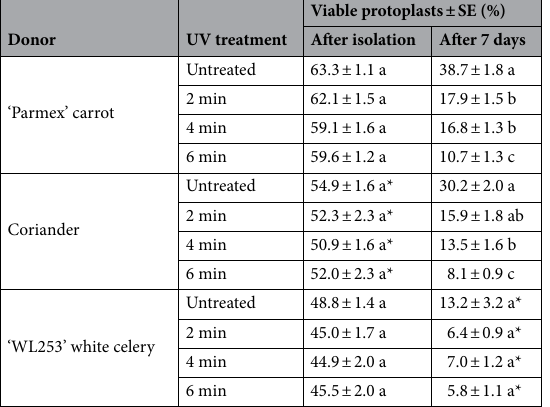
Table 1. Viability (%) of donor (carrot, coriander and white celery) mesophyll protoplasts upon UV treatment. Data shown are means (n = 6, ± SE). a, b, c significant differences based on Tukey’s honest significant test, p < 0.05. a* no significant differences between the groups based on Welch’s robust tests of equality of means, p <